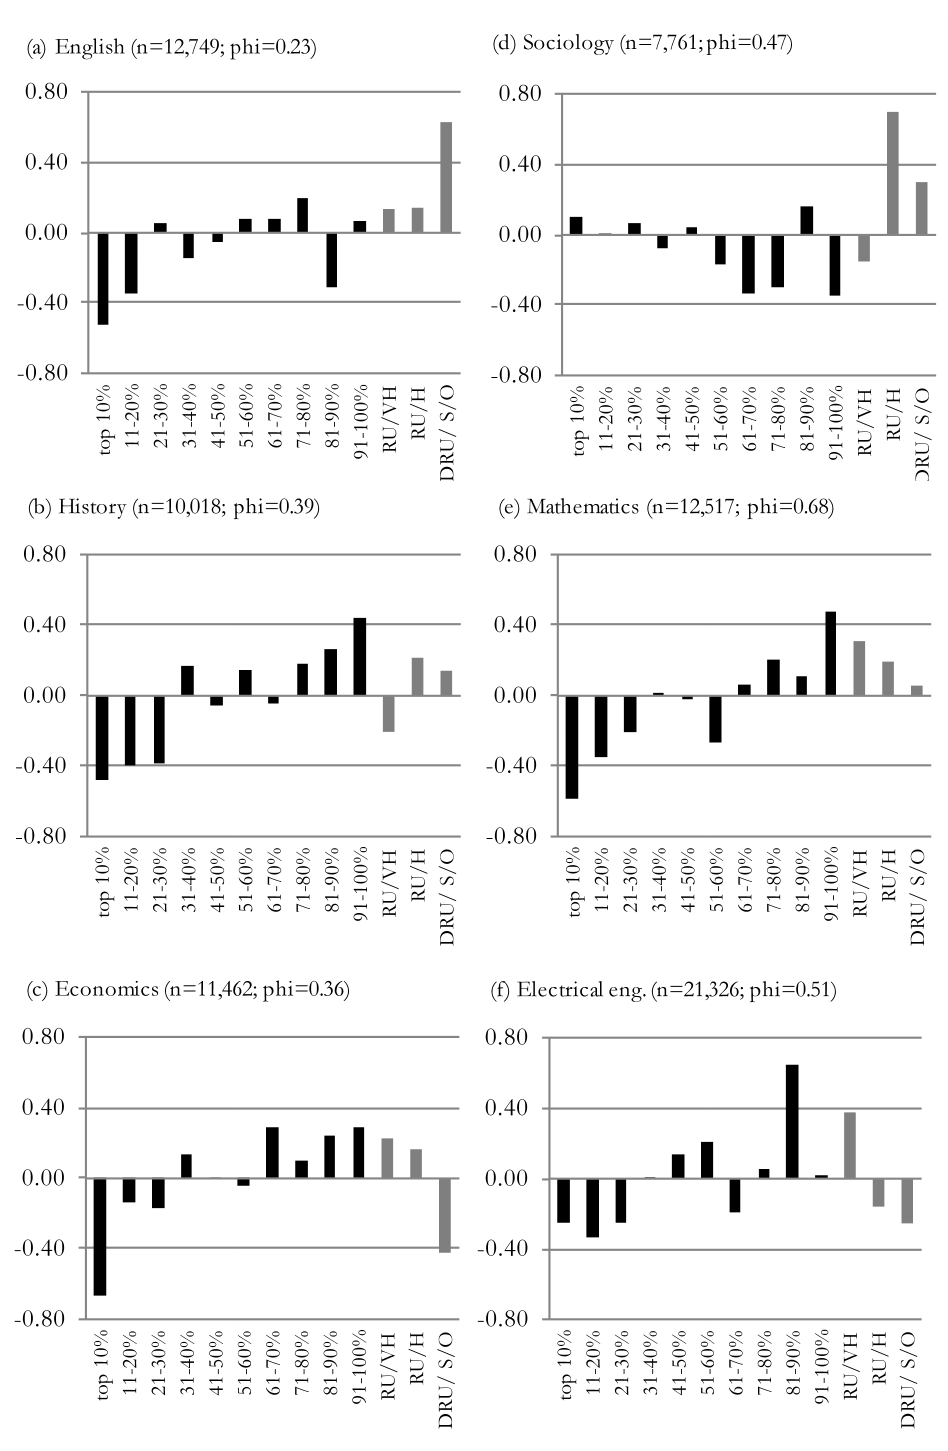
Figure 4: Prestige segregation scale values from saturated model, selected fields. Notes: Phi indicates the overall strength of segregation, and positive values indicate female overrepresentation. Lighter shaded bars are unranked programs. Data source: IPEDs 2003–2014. sociological science | www.sociologicalscience.com